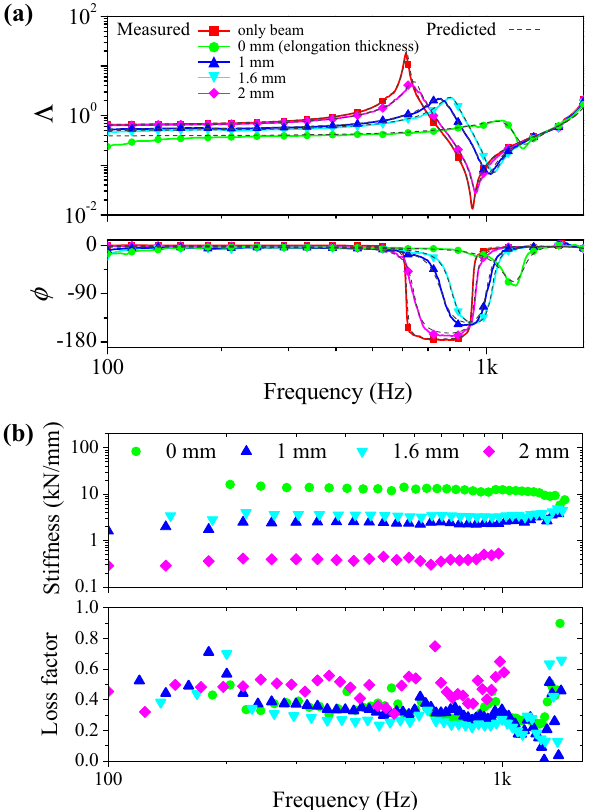
Figure 4. ( a ) Comparison of the predicted and measured vibration responses of the cantilever for different thicknesses of the probabilistic fastener. ( b ) The stiffness and loss factors of the probabilistic fastener calculated from the measured vibration